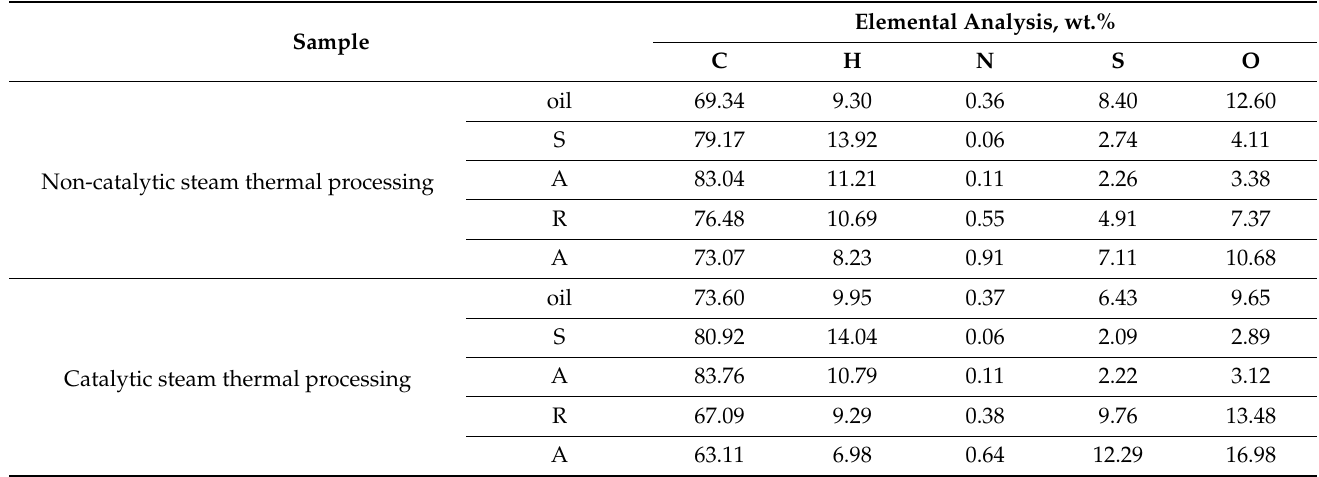
Table 5. Elemental analysis of catalytic and non-catalytic aquathermolysis